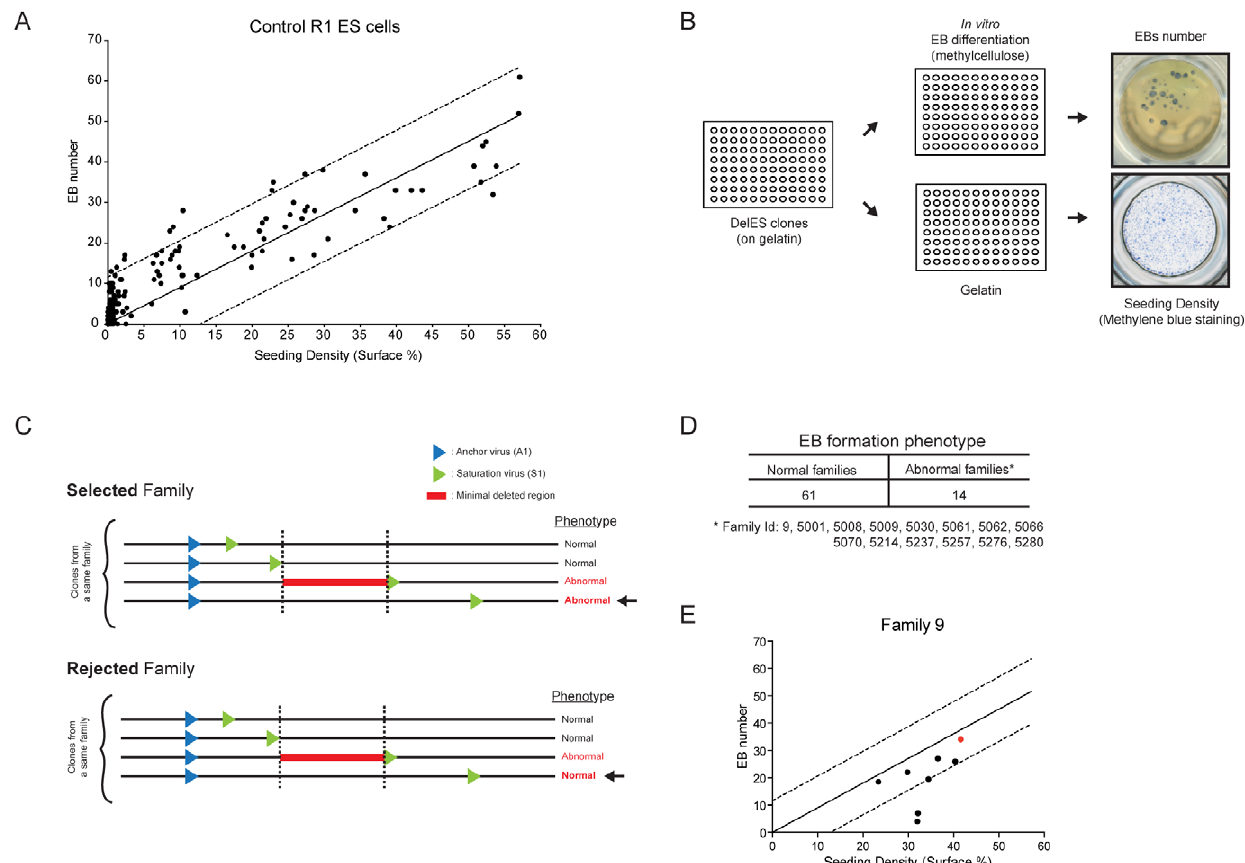
Figure 5. Embryoid body formation screen. (A) Correlation of R1 control ESC seeding density versus embryoid body formation Linear regression curve from control cells is shown 6 1 SD (B) Screen setup. Normalized master plates were thawed on irradiated feeder cells (MEF), before being seeded on gelatinized plates prior to differentiation. After trypsinization, cells were plated in parallel, at equal volumes, in a gelatinized plate and in a 96 well plate containing semi-solid differentiation media. Cells in gelatinized plates were stained 24 hours after seeding with methylene blue (seeding density) and EB number was assessed 8 days after seeding. (C) Phenotype identification of selected vs rejected families using criteria described in text. (D) Phenotype identification in DelES families. (E) Distribution of family 9 clones in the screen setup described in B. Linear regression curve from control cells is shown 6 1 SD. Outliers correspond to abnormal clones 9–18 and 9–37 which are used in complementation studies (Figure 6 and Figure 7). Red dot corresponds to primary clone 9.